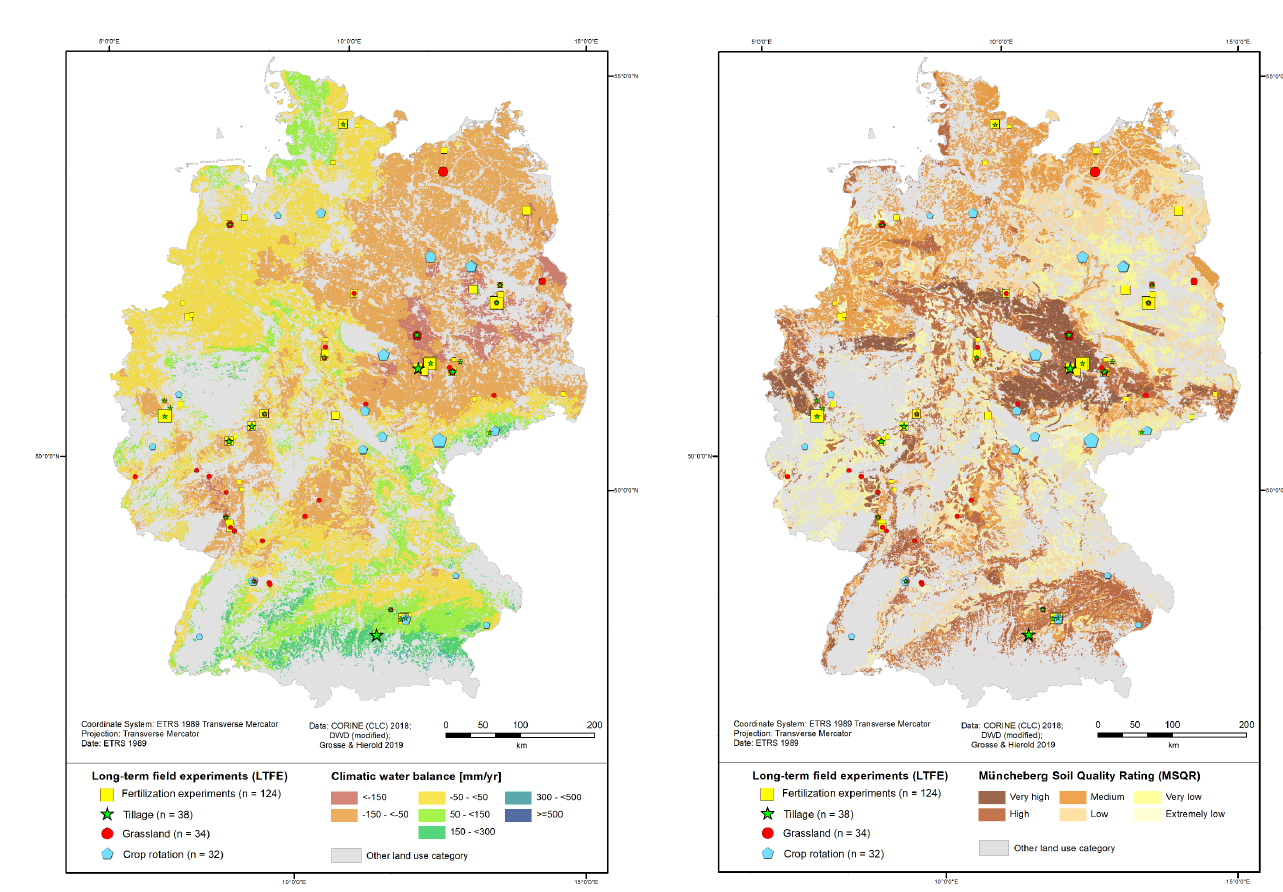
Figure 4. Overview of the distribution of the different climatic wa- ter balance classes of the growing season and the different LTFE types in Germany. The size of the symbols varies according to the number of LTFEs at one place.